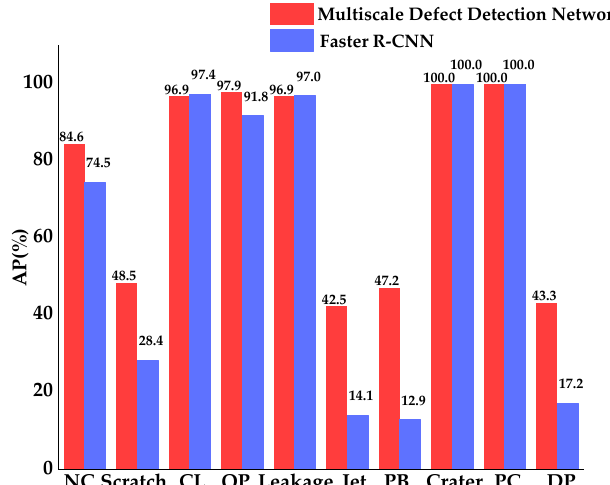
Figure 11. Average precisions (APs) for ten types of defects of Faster R-CNN and the multiscale defect-detection network.